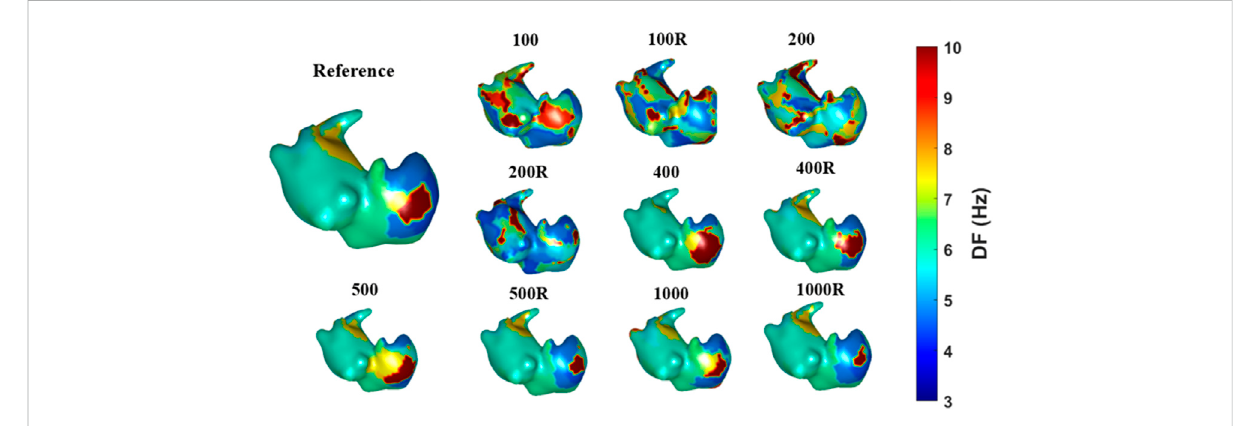
FIGURE 8 Dominant frequency maps obtained with different torso models for one real patient